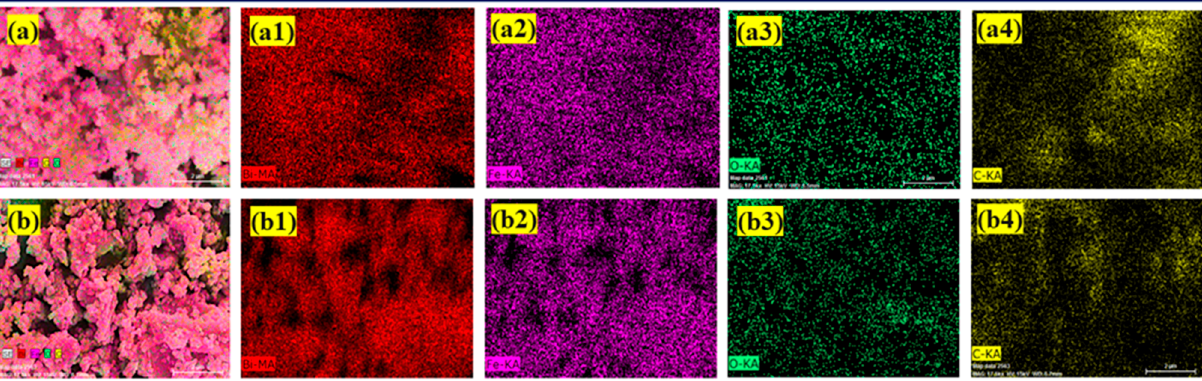
Figure 2. FESEM images of the [BiFe 1 − x Li x O 3 ]-graphene nanocomposite ( a ) x = 0.04 and ( b ) x = 0.06. EDXS Analysis of the [BiFe 1 − x Li x O 3 ]-graphene nanocomposite ( c ) x = 0.04 and ( d ) x = 0.06.